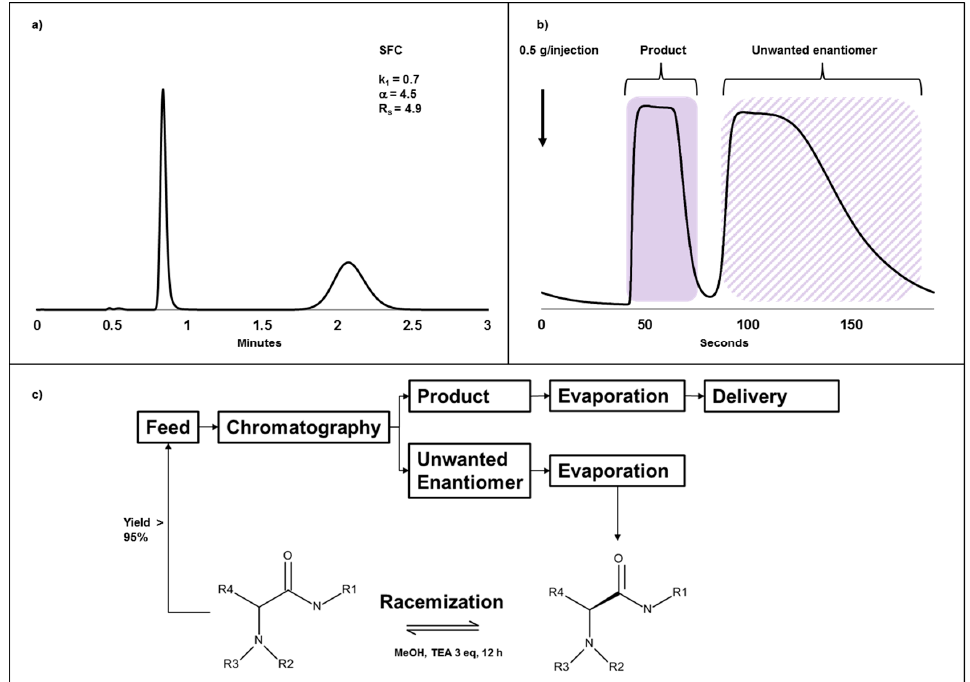
Figure 3. Chiral separation of compound C , a racemic amide. ( a ) Analytical SFC chromatogram using a Chiralart SA 150 mm × 4.6 mm, 3 µ m column. Mobile phase was 40% 2-propanol ( v / v %) in CO 2 at 40 ◦ C, 120 bar and a flow rate of 4 mL/min; ( b ) Preparative chromatogram on Chiralart SA 250 mm × 20 mm, 5 µ m. Then 0.5 g (100 mg/mL acetonitrile) was injected every 190 s using